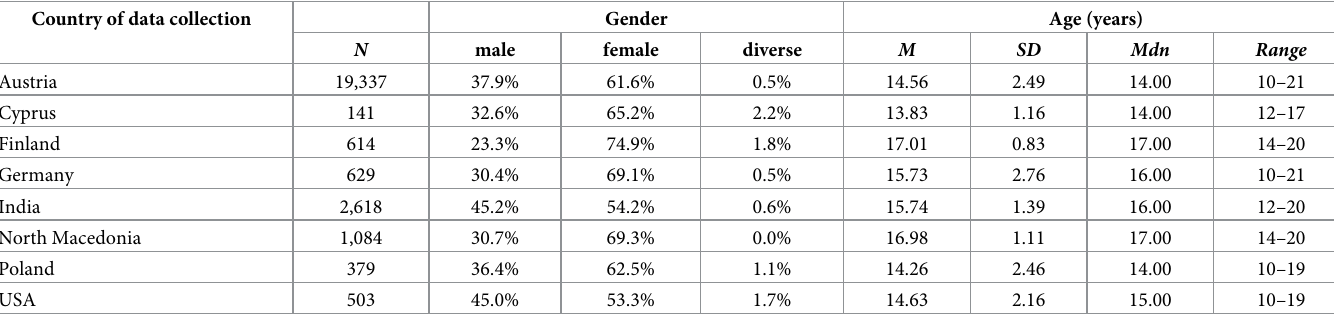
Table 1. Sociodemographic characteristics of participants per